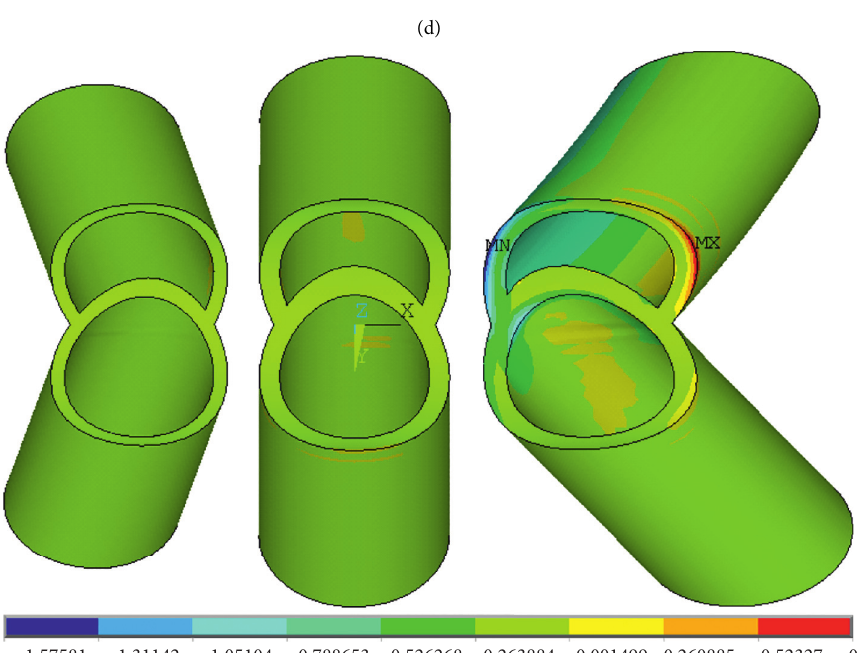
Figure 2: FE modeling of the two-planar overlapped KT-joint: (a) element mesh, stress contours of (b) the chord and (c) overlapping braces under axial loading of unit pressure, and stress contours of (d) the chord and (e) overlapping braces under in-plane bending of unit